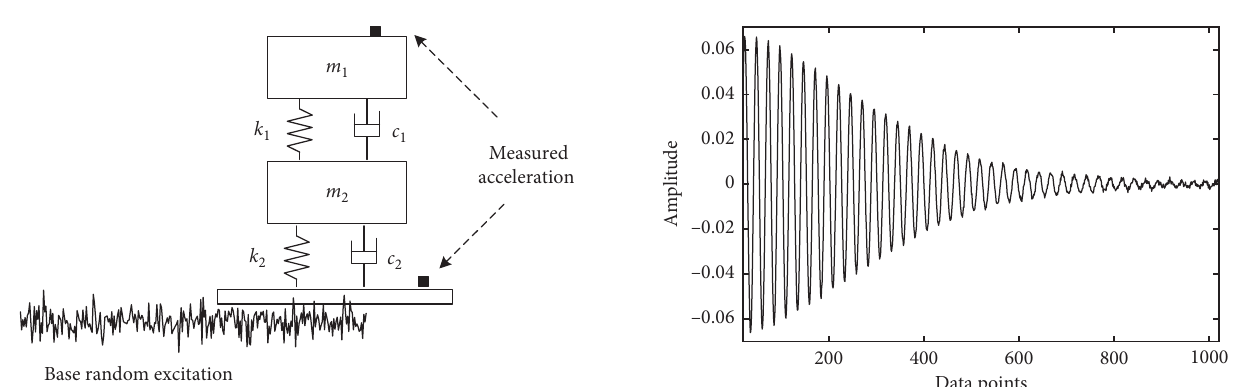
Figure 10: Estimated impulse response from input-output data under random excitation for the two-DOF system.